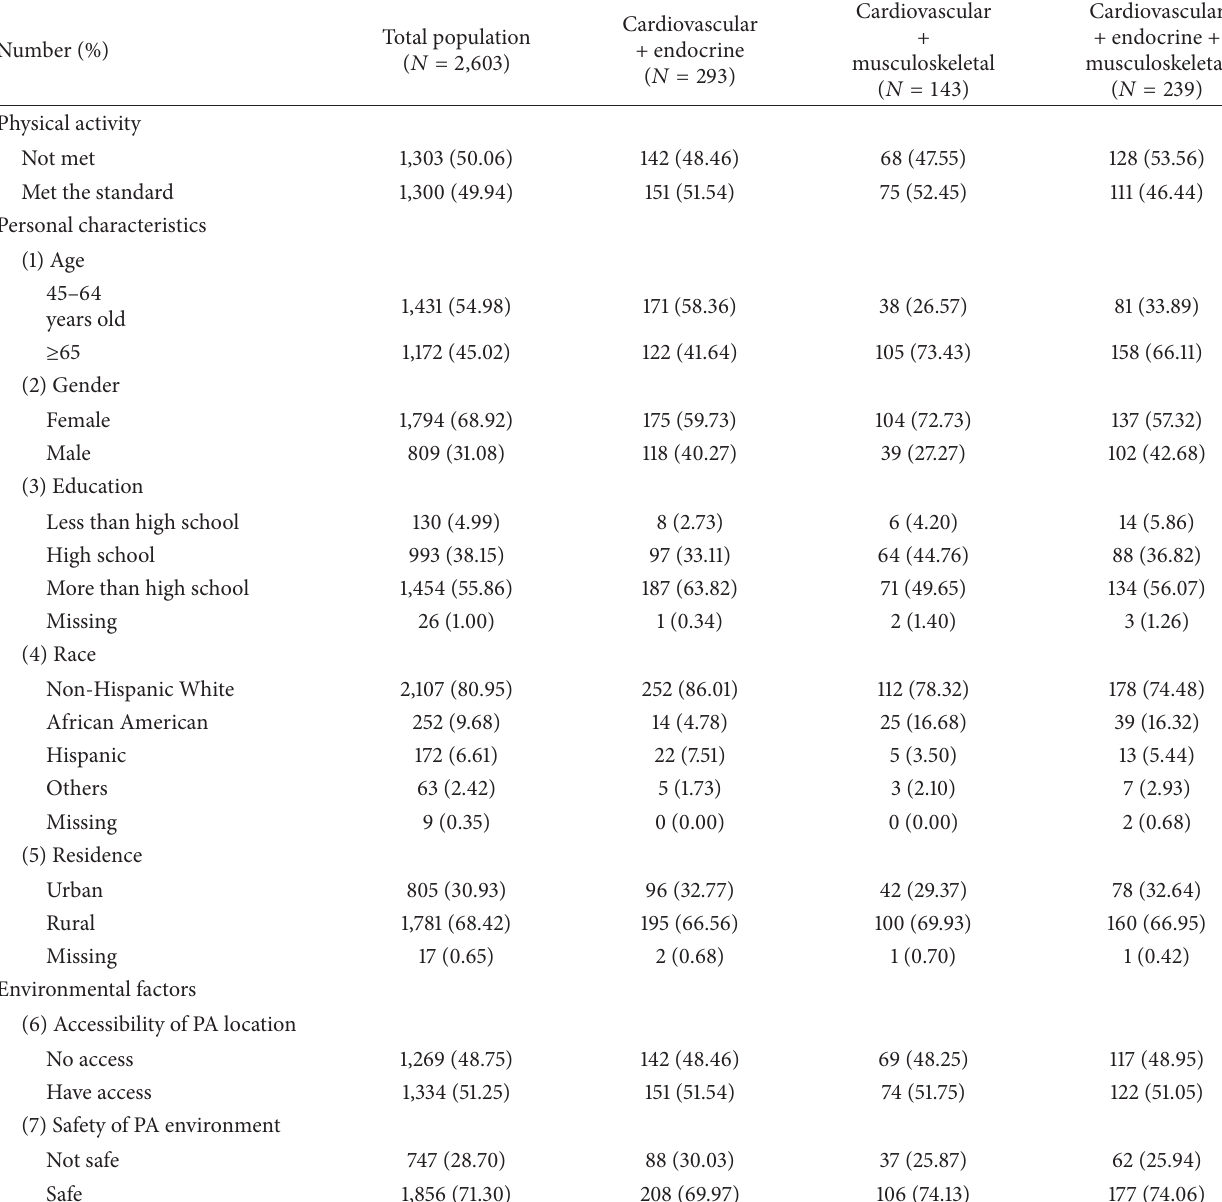
Table 1: Distribution of physical activity, demographics, and environmental